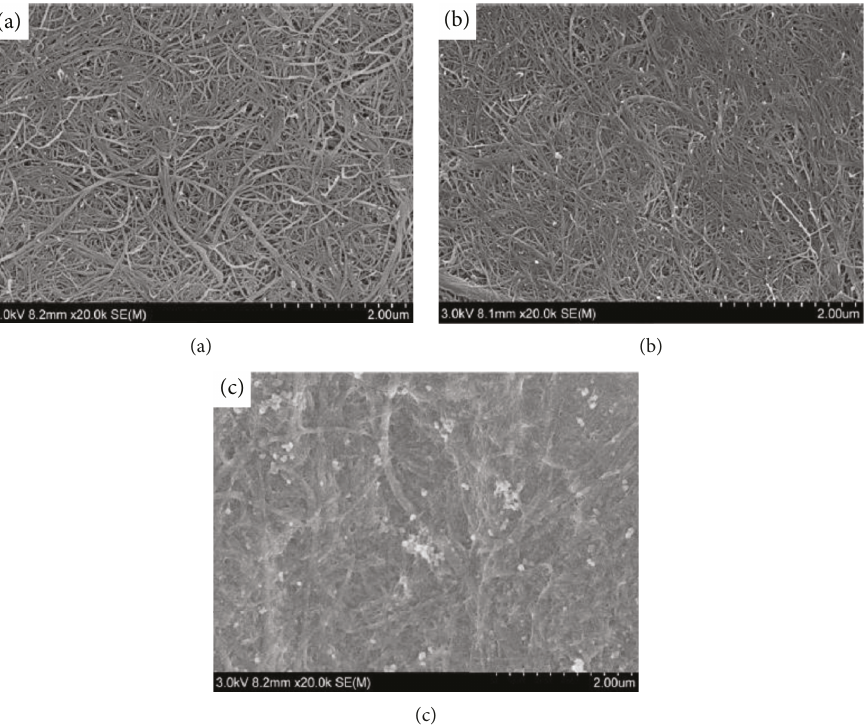
Figure 8: (a) FE-SEM surface micrographs of as prepared CNF nanopaper; (b) the same nanopaper after reaction with acetic anhydride (Ac O); (c) the same nanopaper after overacetylation. Reproduced from reference [44] with permission from 2